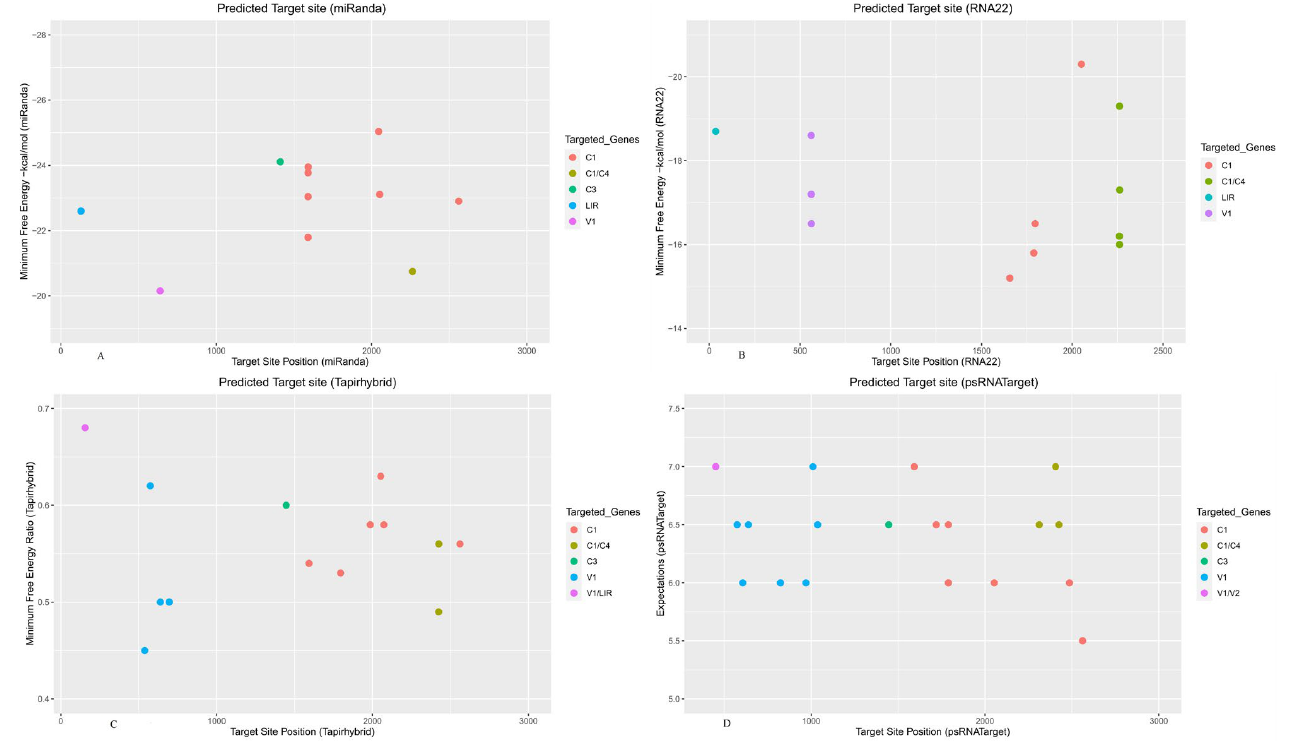
Figure 2. Predicted target binding sites of cassava mes-miRNAs in the ICMV-Ker genome were identified using four selected miRNA-target prediction algorithms. ( A ) The miRNA target binding sites predicted by miRanda. ( B ) The miRNA targets obtained by RNA22. ( C ) Tapirhybrid-predicted potential target binding sites. ( D ) Predicted miRNA targets based on the psRNATarget algorithm. Each colored dot represents one miRNA target binding site, within specific ICMV-Ker genome coding regions. Each viral gene is indicated by a different color, as indicated by the legend shown to the right of the graph, respectively. Table 2. The number of cassava miRNAs to target each gene of ICMV-Ker.